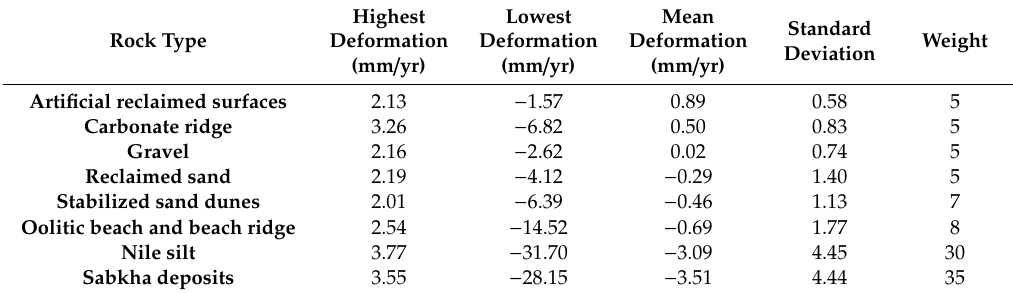
Table 2. Deformation characteristics of each lithological type in